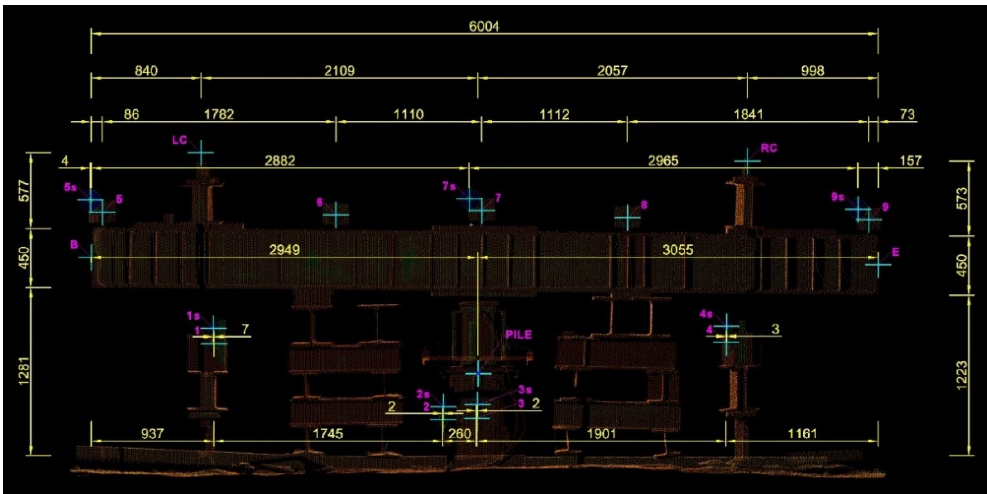
Figure 4. Scanned test stand: schematic layout and numbering of check points.